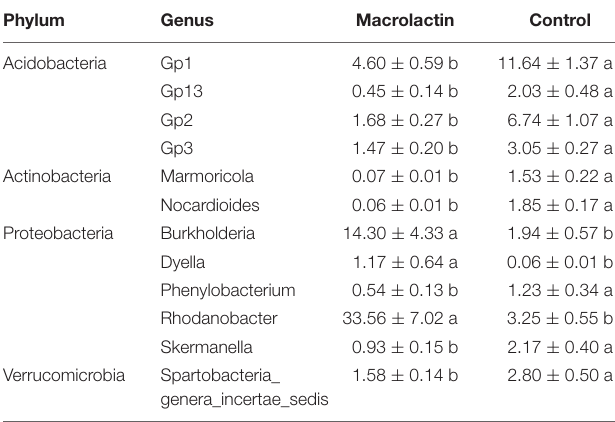
TABLE 1 | Frequency of the most abundant ( > 1%) classified bacterial genera (expressed as %) of all classified sequences within macrolactin treated soil and water control